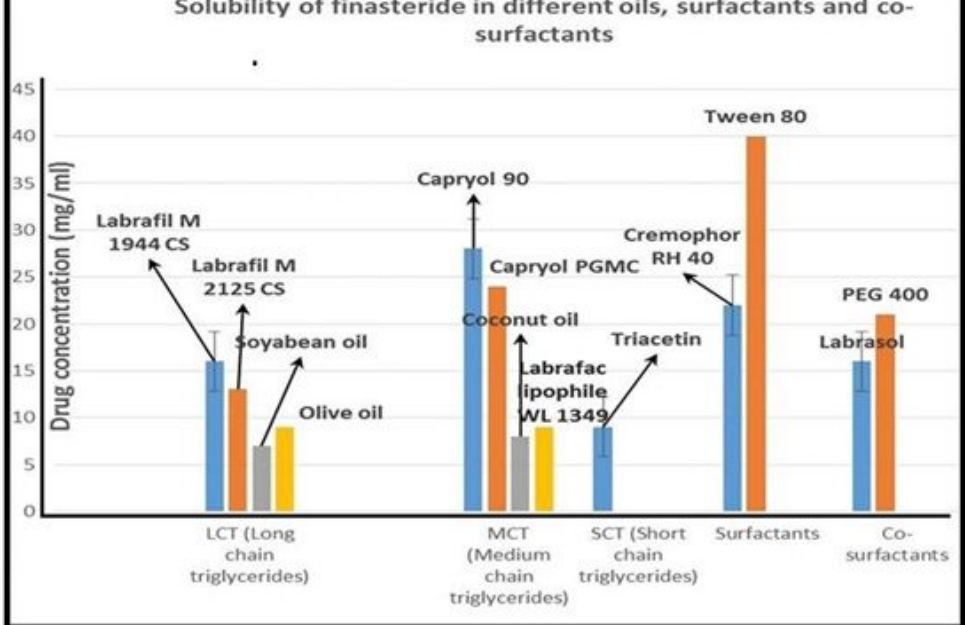
Figure 1. Solubility of finasteride in different oils, surfactants and co-surfactants. Table 1. Finasteride solubilizing capacity and emulsification ability of surfactants and co-surfactants. The results are shown as mean ± S. D.